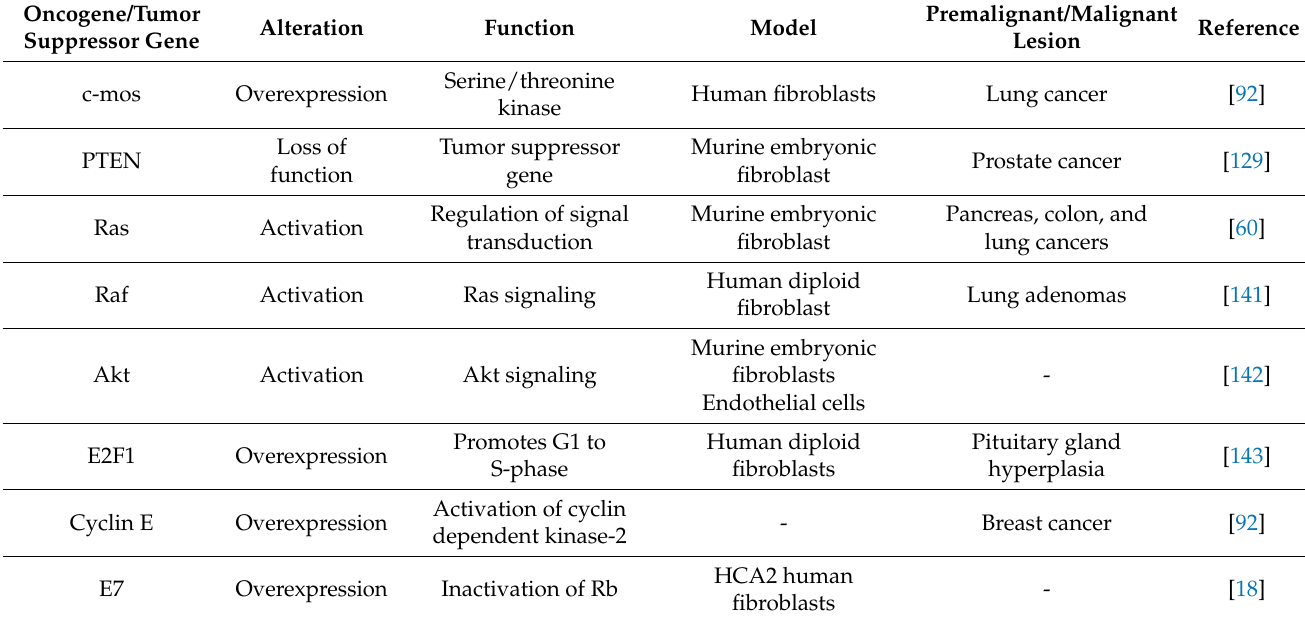
Table 2. Examples of established oncogene/tumor suppressor genes implicated in the induction of Oncogene-Induced Senescence